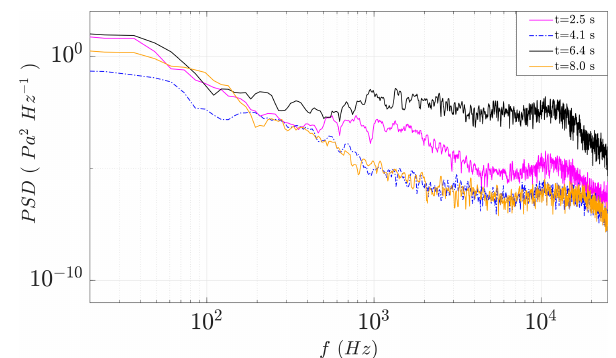
Figure 4. Comparison of the PSD from different time indices for the same microphone placed at x/c =